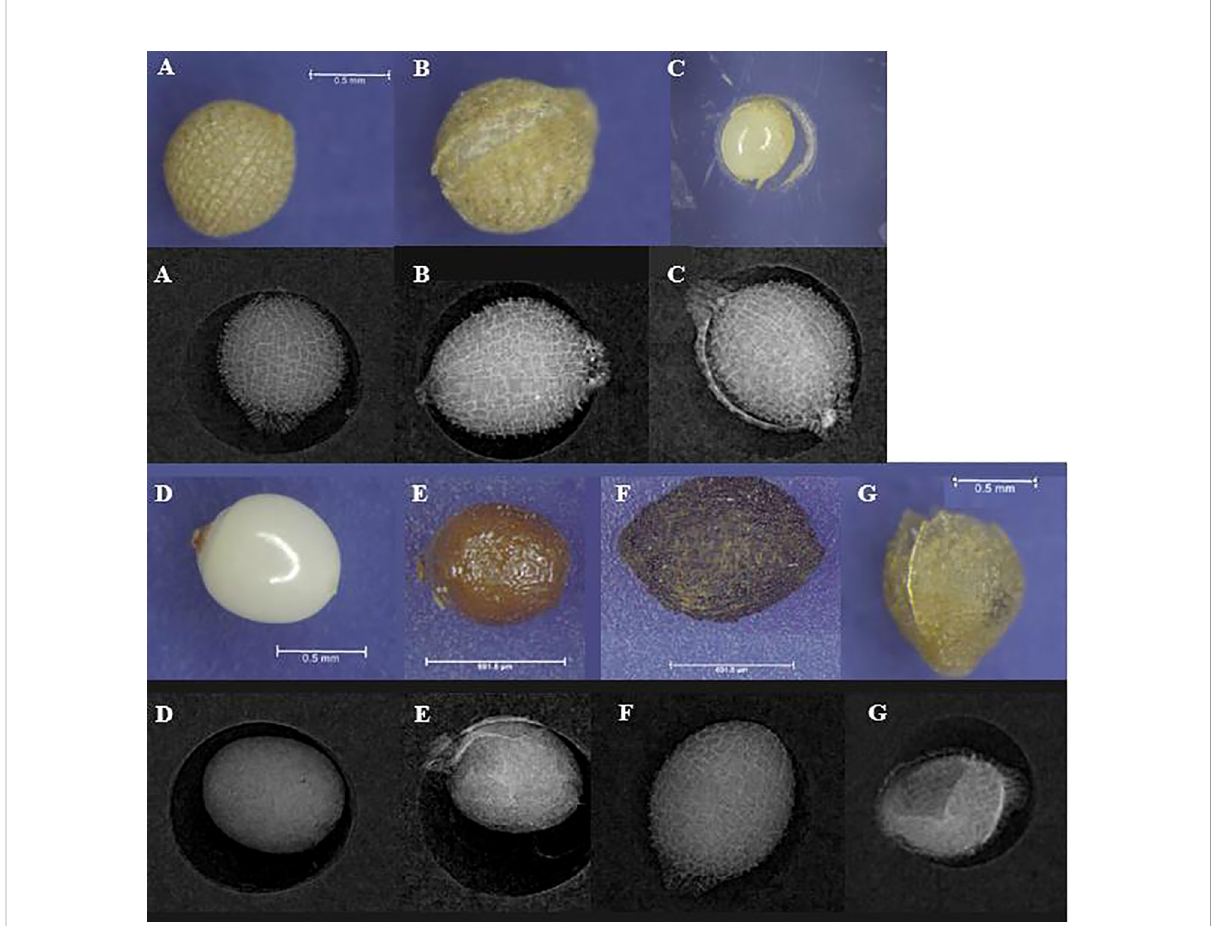
FIGURE 3 The X-ray images and microscope photos of H. ovalis seeds. (A) intact seed coat; (B) intact endocarp with small-scale broken seed coat and intact endocarp; (C) intact endosperm and endocarp with large-scale broken seed coat; (D) intact endosperm without endocarp; (E) soft seed; (F) dark seed with unhealthy endosperm; (G) seed coat. (A – C) were considered as viable seeds, and (D – F) were considered as non-viable